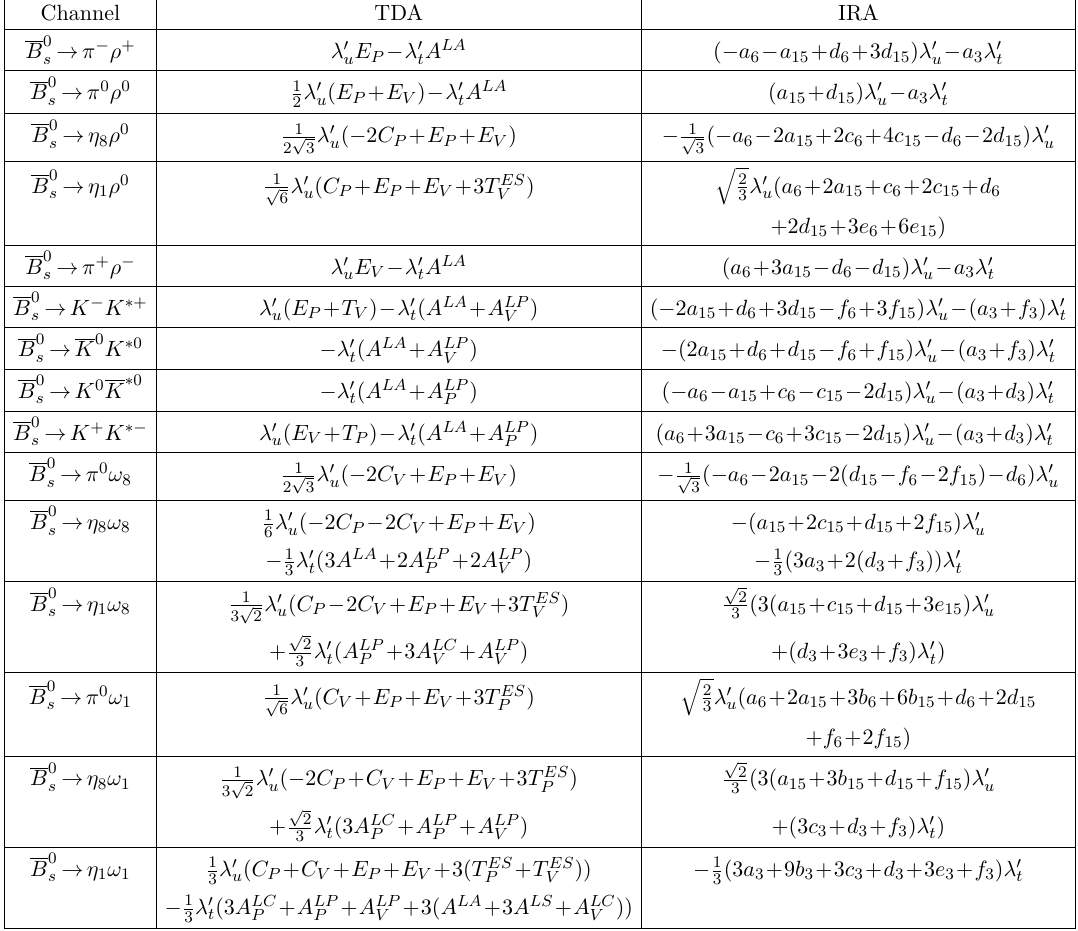
Table 11 . Decay amplitudes of the B s → PV decays induced by the b → s